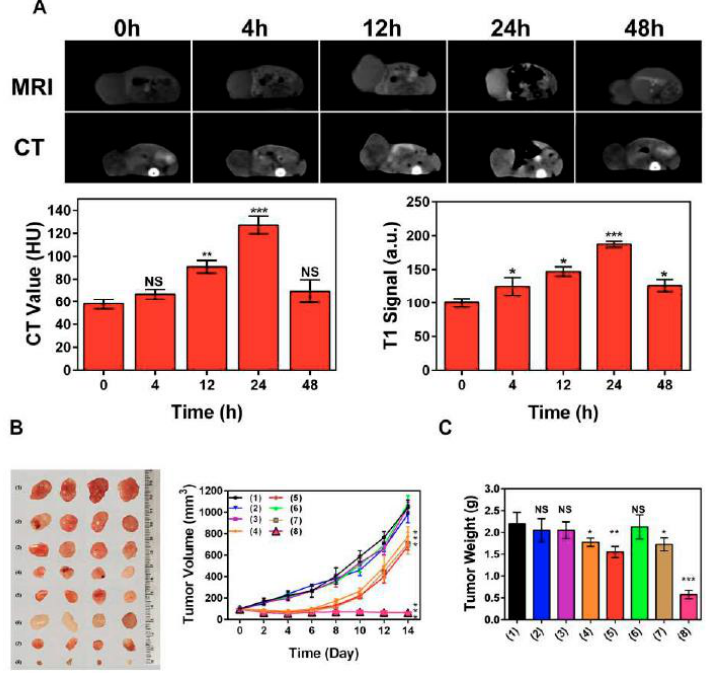
Figure 9. PES-Au@PDA NPs synergistic GBM treatment and multimodal imaging in vivo. ( A ) CT and 3 T1-weighted MR images were acquired at the indicated times (0, 4, 12, 24, 48 h)